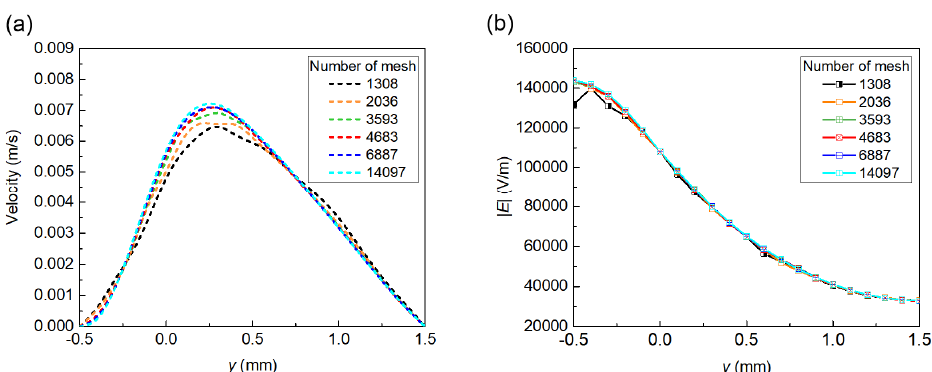
Figure A4. ( a ) Distribution of the flow velocity ( b ) Distribution of the electric field, for different numbers of elements: x = 15 mm, 𝑢 (cid:2869) = 2.5 mm/s, 𝑢 (cid:2870) = 1.5 mm/s, U 0 = 152 V eff , 𝜎 (cid:3040) = 1 mS/m and f = 100 kHz.